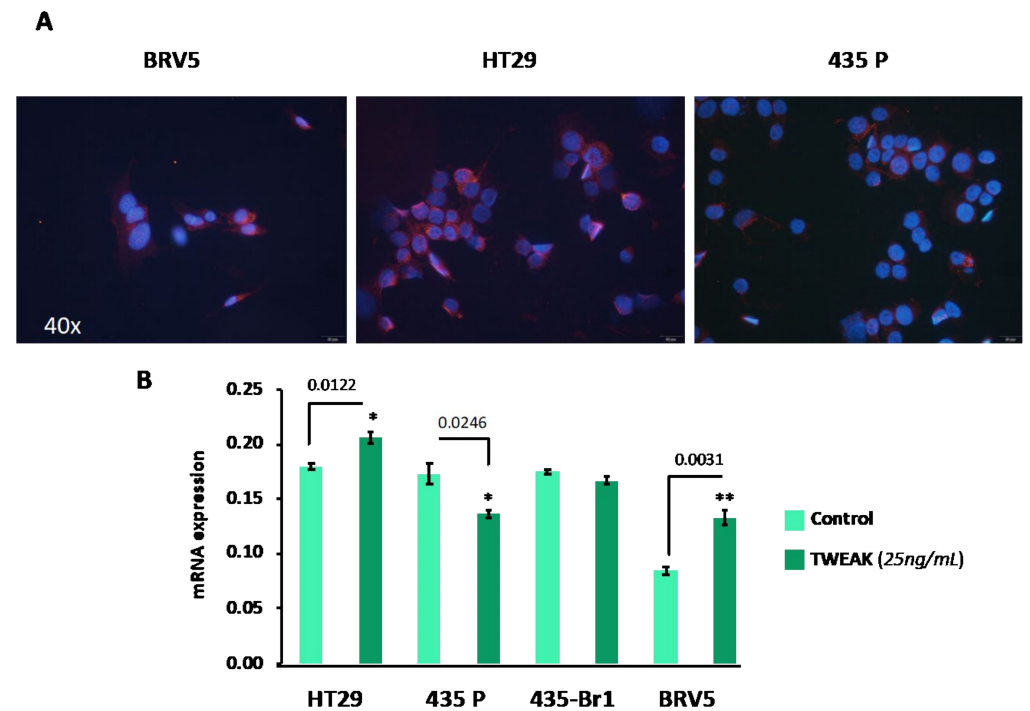
Figure 1. Characterization TWEAK-dependent/not dependent cells. ( A ) Representative images of Fn14 expression (pink) in BRV5, 435-P and HT29 cells labelled by immunofluorescence. The protein has similar expression in BRV5 and the positive control HT29 cells, and less expressed in 435-P. DAPI (blue) was used for nucleus identification. ( B ) RT-PCR analysis to quantify Fn14 gene expression of cells cultured in the presence (dark green) or absence (light green) of TWEAK (25 ng/mL) at 48 h. Up-regulation of Fn14 is observed only in HT29 and BRV5 cells. Bars and error bars represent the average and standard deviation as calculated from three replicates respectively. P values represented as: * - significant (Pvalue: 0.01 to 0.05) and **- very-significant (Pvalue: 0.001 to 0.01).